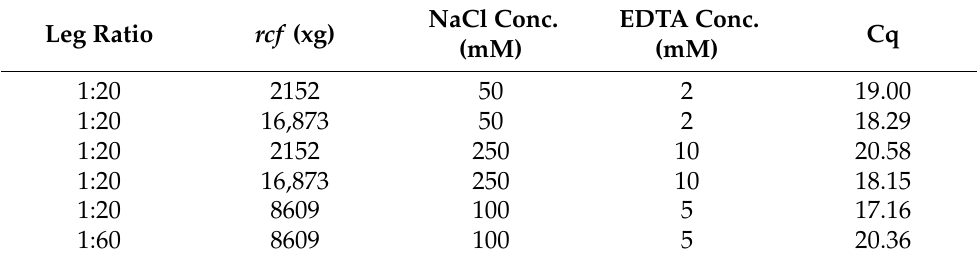
Table 3. Real-time PCR results from high salt formulations of squish buffer. Leg ratios are H. armigera : H. zea .